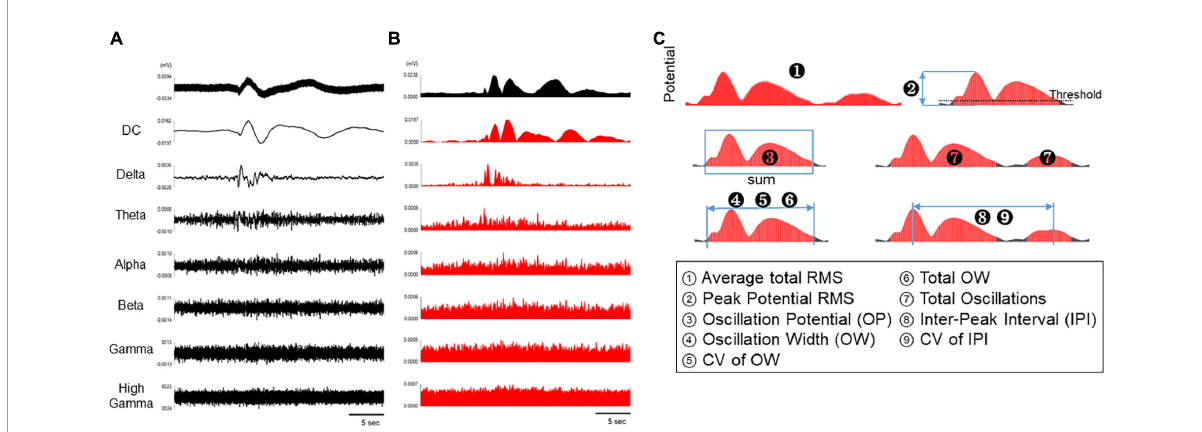
FIGURE2 Analytical parameters of spontaneous activity in human primary astrocytes. (A) Representative oscillation waveform of spontaneous activity in human primary astrocytes at 3 DIV (top), and waveform separated into seven frequency bands (DC, 0.1–1 Hz; delta, 1–4 Hz; theta, 4–8 Hz; alpha, 8–14 Hz; beta, 15–30 Hz; gamma, 35–50 Hz; high gamma, 80–150 Hz). (B) The waveforms in each frequency band were converted into RMS histograms. (C) Schematic diagram of analysis parameters. The red area are subject to analysis for each